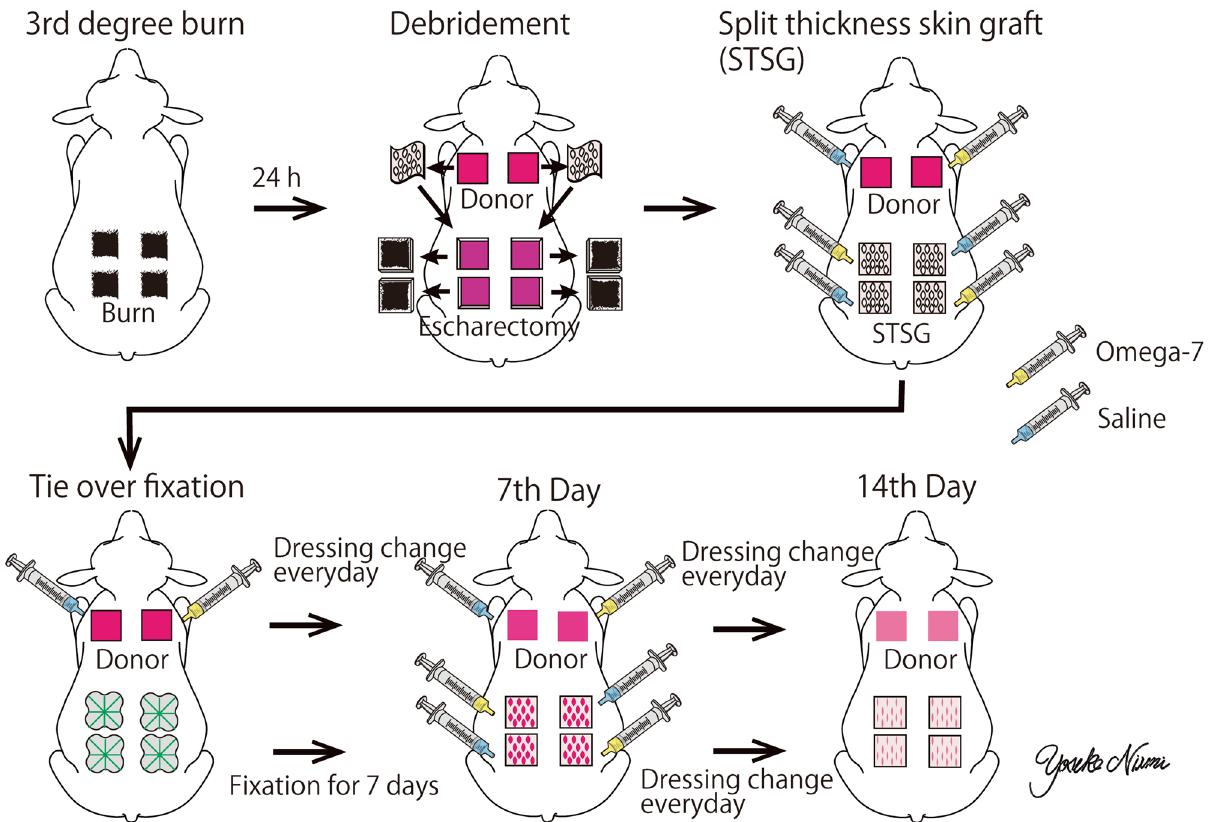
Figure 8. Experimental design of clinically relevant ovine grafted burn wound healing model. The third-degree burn was induced by fire flame (above left). 24 h after the burn, the eschar was excised down to the fascia. Split- thickness skin grafts 0.03 inches thick were harvested from sites remote from the burned sites to be meshed and grafted to the wounds (above center). 0.1 ml/cm 2 of 4% Omega-7 in 0.9% saline was topically applied to one of two randomly selected autografted sites (Omega-7 group). The remaining site received the same amount of 0.9% saline as a control (control group). The donor sites were also randomly allocated to 0.1 ml/cm 2 of 4% Omega-7 or 0.9% saline (above right). After the initial treatment, the grafted sites were covered with tie-over dressings removed at postoperative day (POD) 7 (below left). At the 7 days after the grafting, the wounds were gently washed daily with a sterile saline without anesthesia (below center). Thereafter, the wounds were treated with Omega-7 or 0.9% saline, and covered with polyurethane foam for 7 days (14 days total duration of experiments). The donor site wounds were covered with polyurethane film dressing and treated daily with 4.0% Omega-7 or 0.9% saline starting at POD1 for 14 days (below right). The study design was drawn using Adobe illustrator